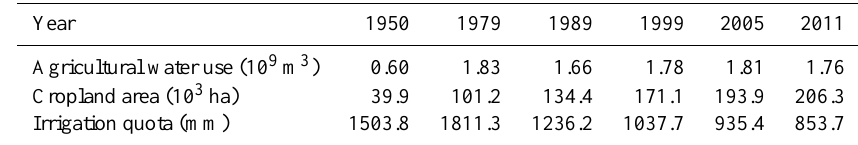
Table 4. Development of irrigation in Kaidu–Kongqi River basin.